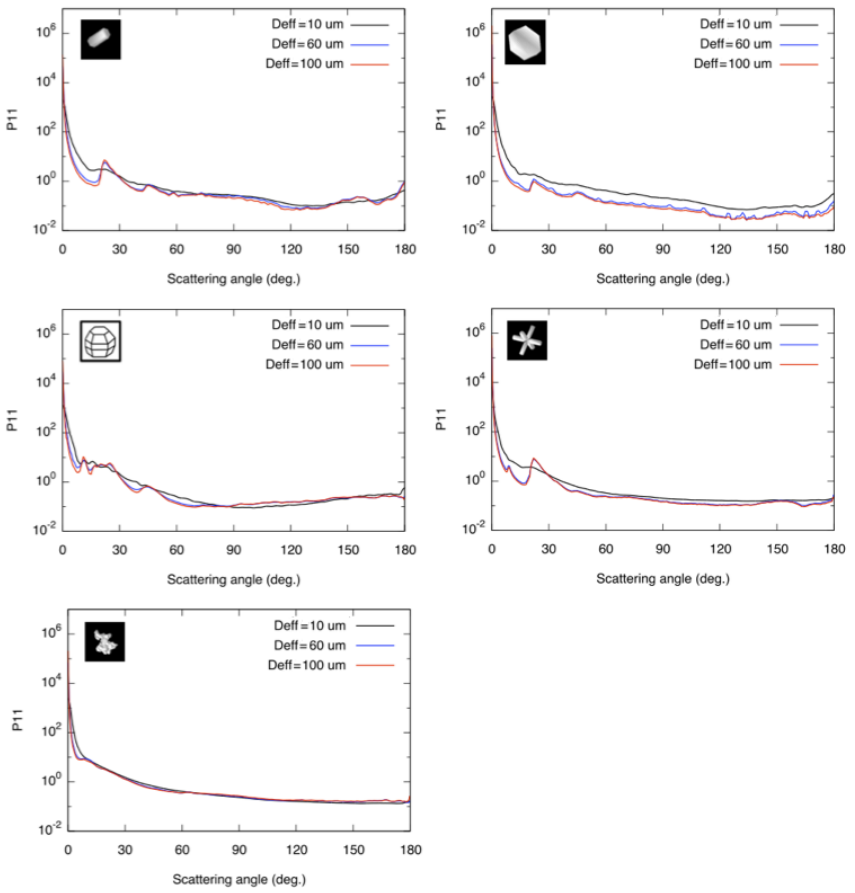
Figure 5. Bulk scattering phase functions of the column, droxtal, plate, bullet rosette, and Voronoi habit employed in this study with various effective diameters at wavelengths of